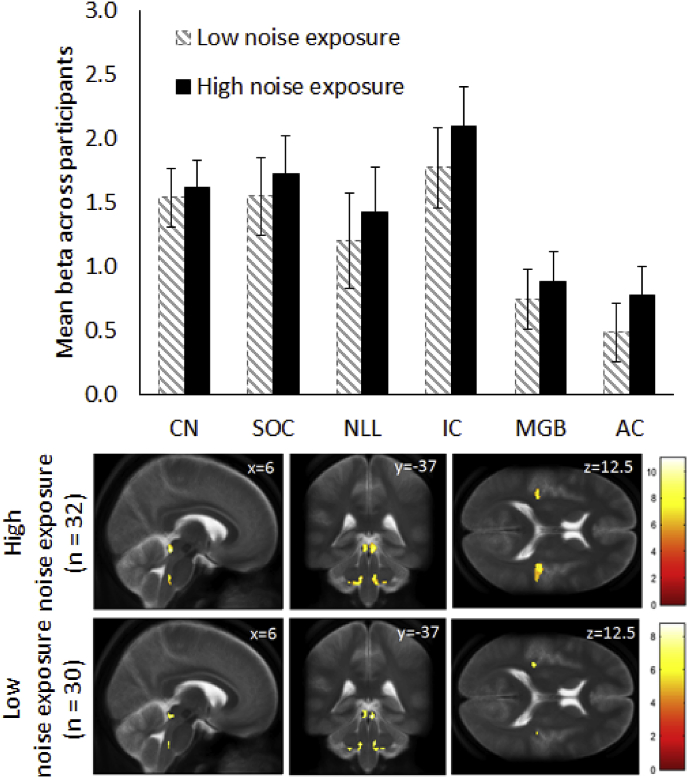
Sustained response: estimated marginal mean ROI beta values for sustained stimulus in ROIs in low and high noise exposure groups. Beta values represent an average over left and right hemispheres, with error bars representing 95% confidence intervals of the mean. Below: random effects group activations to the sustained stimulus for low (n = 30) and high (n = 32) noise exposure groups threshold at p < 0.05 FWE corrected with the color bar showing the T statistic. Numbers within the images denote co-ordinates of sagittal, coronal and transverse slices. Statistical maps are overlaid on the mean (n = 62) T2 TSE image.